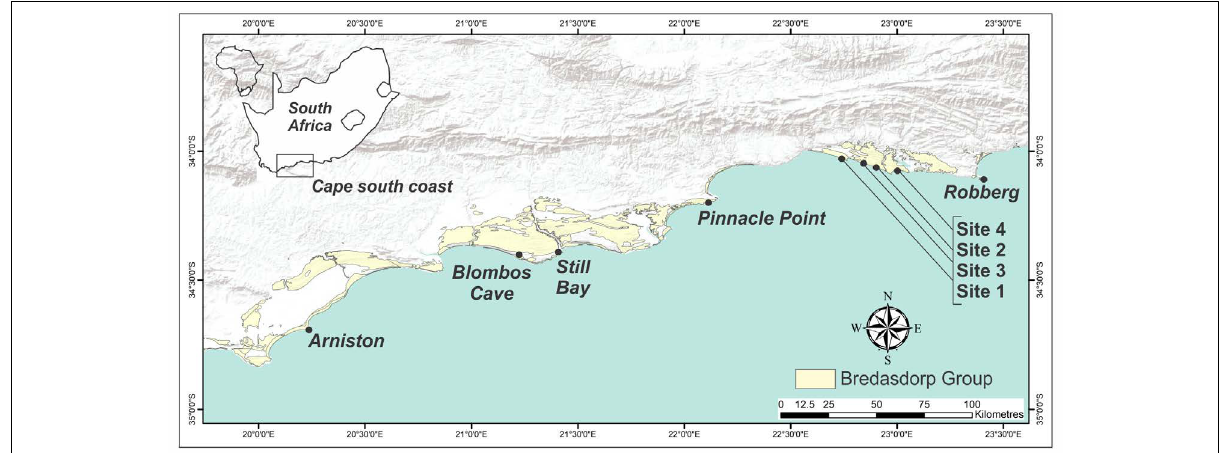
Map of South Africa and the Cape south coast, showing places mentioned and the locations of Site 1 – Site 4, and the extent of outcrops of the Bredasdorp